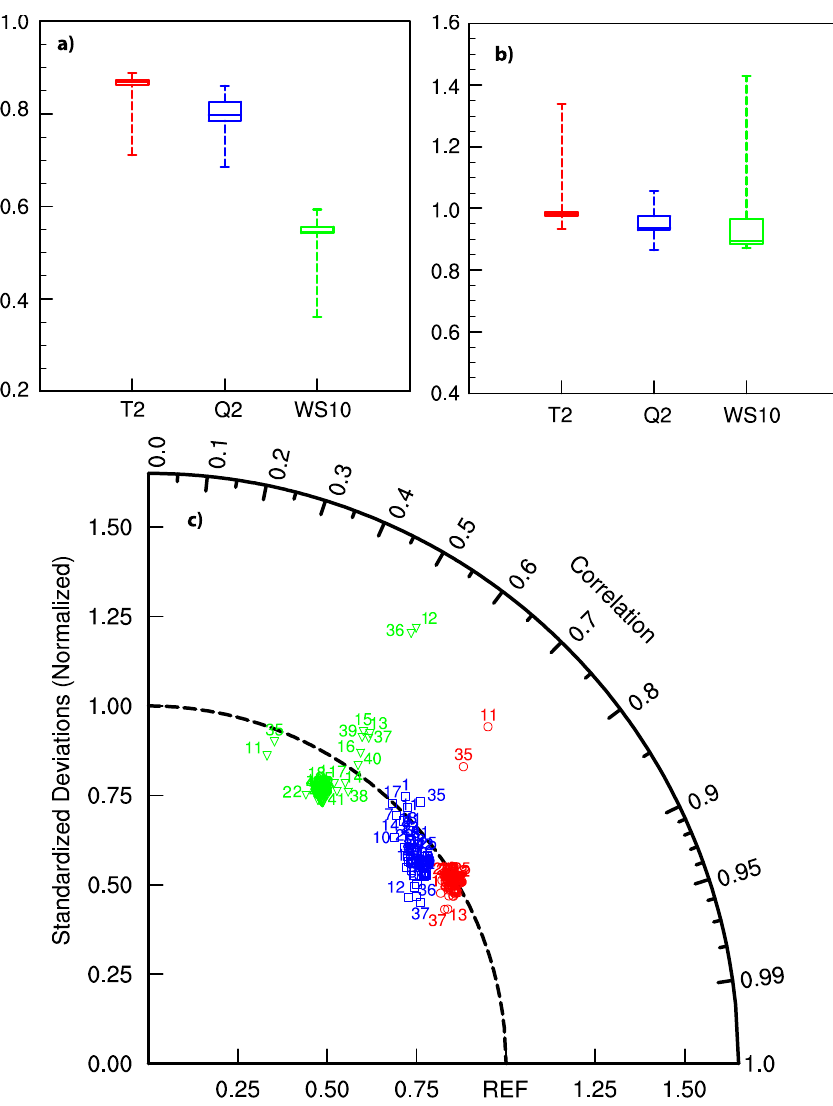
Figure 2. Boxplot of the averages on Domain 3 of ( a ) correlation and ( b ) normalized standard deviation of air temperature at 2 m above ground level (T2) (red), Q2 (blue), and wind speed (WS) (green); and ( c ) Taylor diagram of the analysis during the one-week study period in January 2016. Numbers refer to experiments.